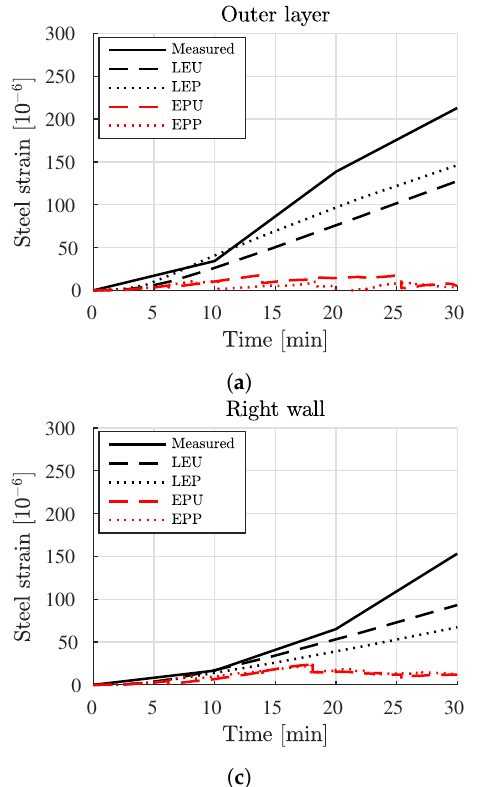
Figure 20. Measured and simulated strains of steel rebar: ( a ) outer and ( b ) inner reinforcement at the midspan of the left cell of the top slab, and ( c ) outer reinforcement at the center of the right wall: strain increments, resulting from application of the thermal loading, considering linear-elastic (LE) or elasto-plastic (EP) material behavior of concrete and a prescription of one uniform surface temperature history (U) or of three different piecewise uniform surface temperature histories